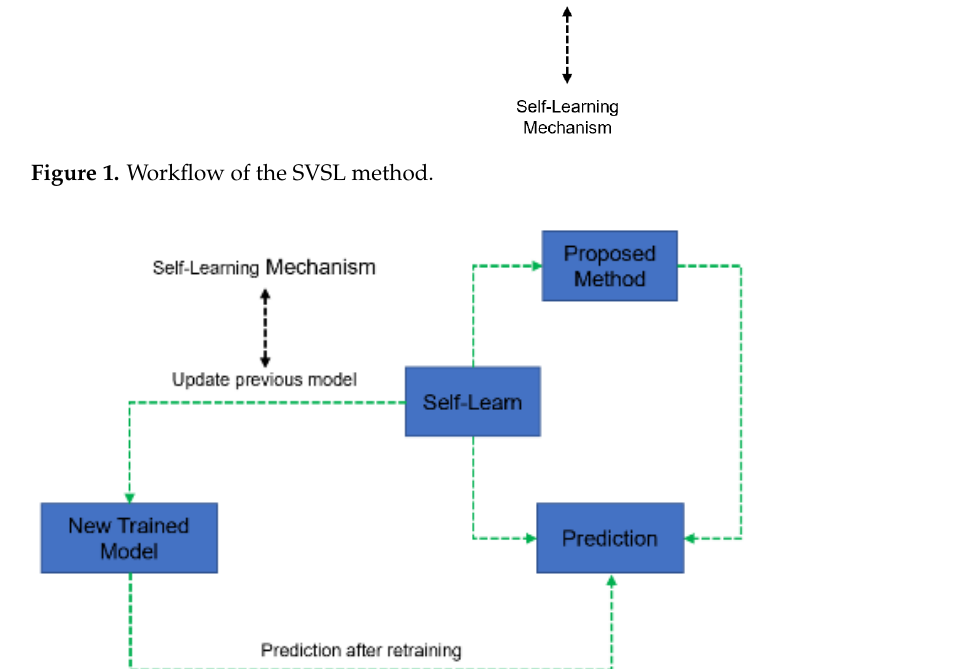
Figure 3. Prediction accuracy (%) of different DL models.